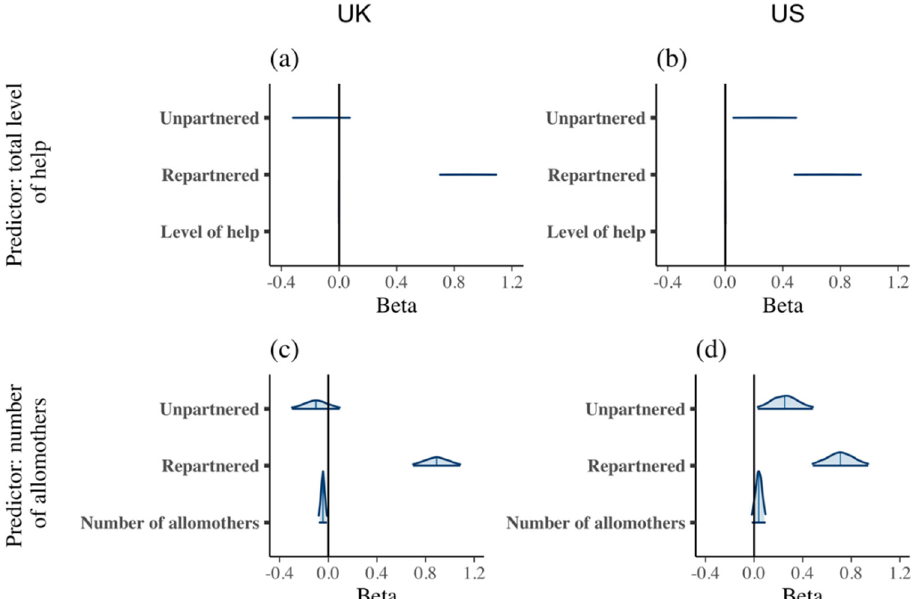
Figure 5. Plots showing the posterior distributions (95% credibility intervals) for the major predictors and control variables in the models of age-adjusted fertility as a function of: ( a , b ) total level of childcare help received and ( c , d ) total number of allomothers in the allomaternal network. Reference category for unpartnered and repartnered women is partnered women; level of help and number of allomothers are entered as continuous predictors.